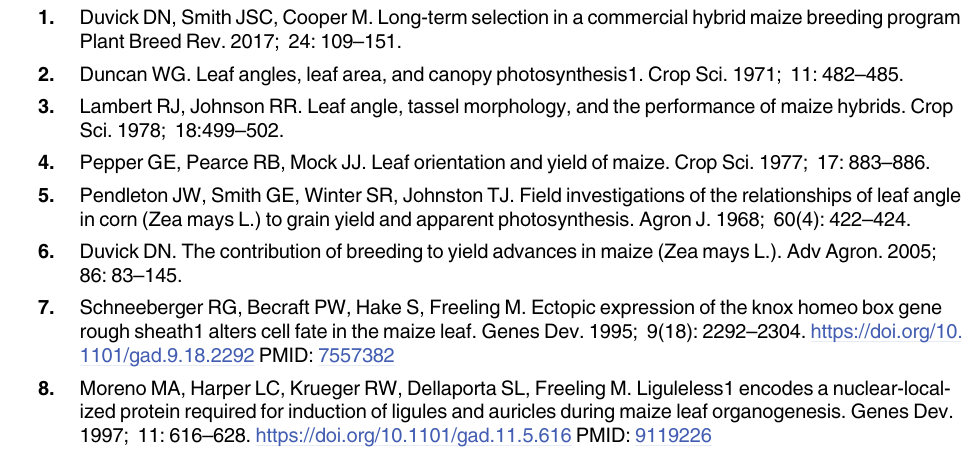
S1 Fig. The basic situation of the sequencing depth distribution. S2 Fig. Genome wide distribution of read coverage. The horizontal axis is the chromosomal position, and the vertical axis is the median of read density of the corresponding position on the chromosome (log (2)). There is no significant difference at the 5% level. Error bars indicate the standard deviation of the phenotypic values for each genotype. S1 Table. RT-qPCR primer. S2 Table. Whole genome resequencing results of